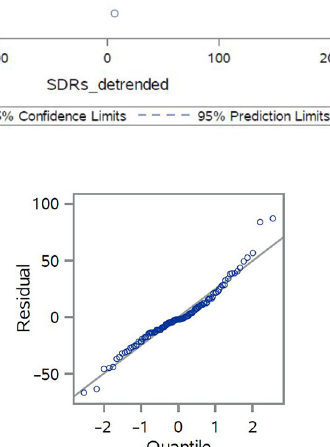
Figure 11. AFGSC Cann QQ